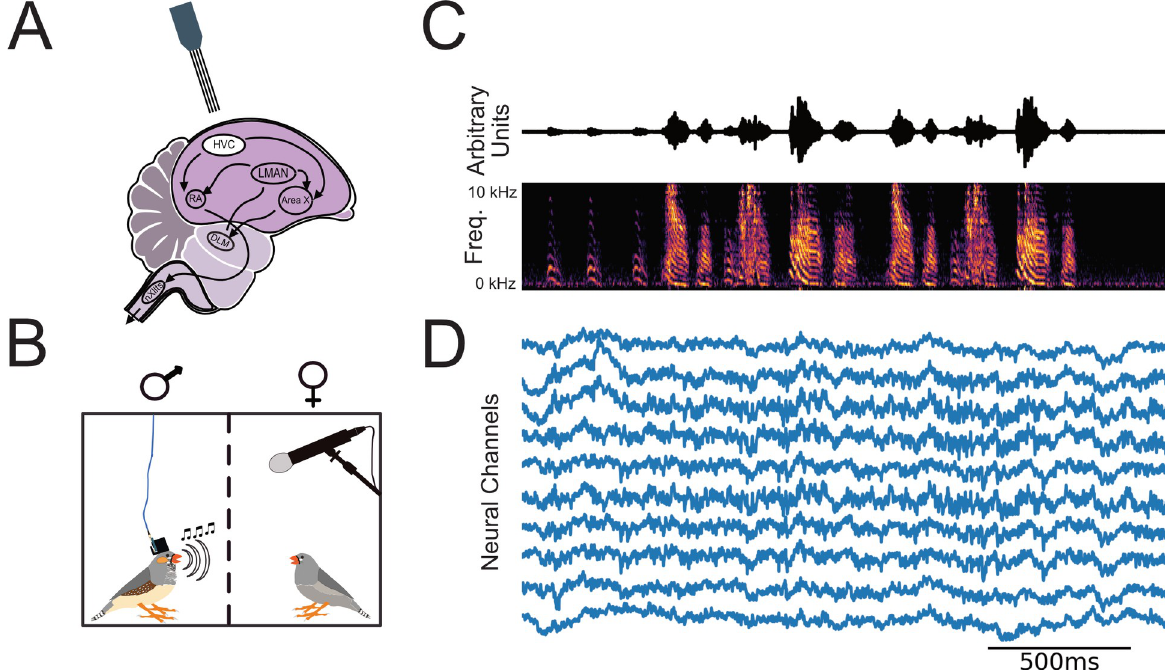
Fig 1. Continuous electrical and audio recording of chronically implanted freely behaving male zebra finch (Methods). (A) Four-Shank multi-site Si-Probes were chronically implanted targeting nucleus HVC. HVC provides input to two motor pathways that innervate neurons in the tracheosyringeal half of the hypoglosssal nucleus (nXIIts) that projects to vocal muscles. The posterior descending pathway (PDP) comprises a direct projection to the robust nucleus of the arcopallium (RA) and is necessary for both the acquisition and production of learned vocal behavior (song). The anterior forebrain pathway (AFP), provides an indirect pathway to RA, through Area X, the dorsolateral anterior thalamic nucleus (DLM), and LMAN, and is necessary for song acquisition. The PDP is homologous to a motor pathway in mammals that starts in the cerebral cortex and descends through the brain stem, while the AFP is homologous to a cortical pathway through the basal ganglia and thalamus. (B) Neural and audio recording apparatus. We recorded LFP and vocal activity from male zebra finches stimulated to sing by the presence of a female conspecific. (C) Exemplar sound pressure waveform (1.3 seconds in duration, top) from bird z007 above the corresponding spectrogram. (D) Voltage traces ( μ V) of ten randomly selected channels of simultaneously recorded neural activity aligned to the song during audio recording, after a 400 Hz low-pass